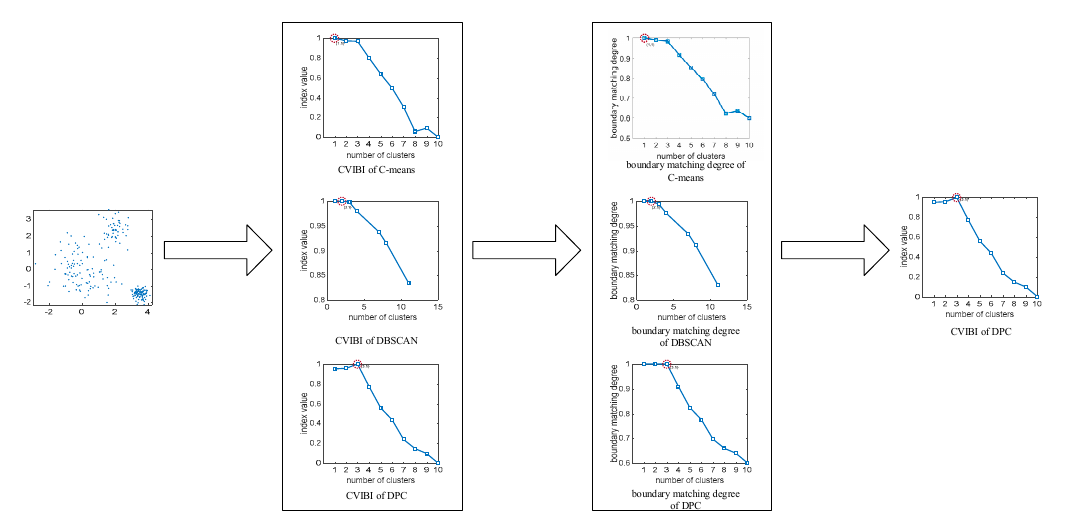
Figure 14. Evaluating the process of CVIBI on the overlapped dataset.